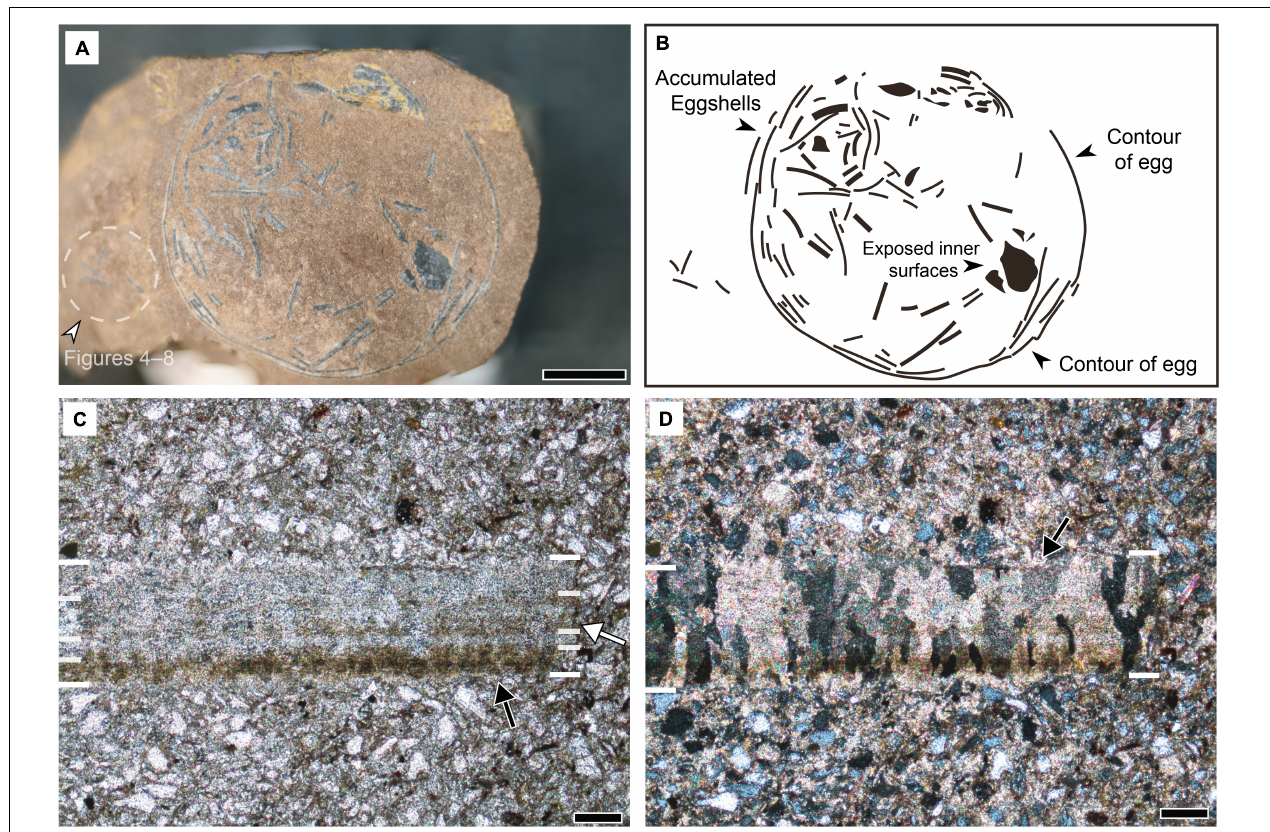
FIGURE 5 | Macroscopic and microstructural features of Aenigmaoolithus vesicularis oogen. et oosp. nov. (A) A cross-section of the holotype (SNUVP 201701). The eggshell fragments nearby the holotype (a white arrowhead and dashed circle) are used for physico-chemical analyses. (B) A schematic view of the holotype egg. (C) PLM view under normal light (SNUVP 201702). At least four layers are identified: innermost dark band (a black arrow), inner translucent layer, middle pale dark band (a white arrow), and outer translucent layer. The boundaries are marked by white bars. (D) PLM view under polarized light (SNUVP 201702). Extinction pattern is irregular, columnar, and wedge-like (a black arrow). Scale bars equal 5 mm (A) ; 100 µ m (C,D)